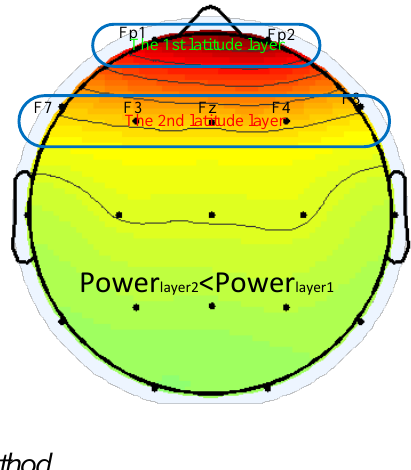
Figure 1. Power topographic of the blink components and two different layers according to different latitude line. The power in the second layer must be less than the one in first